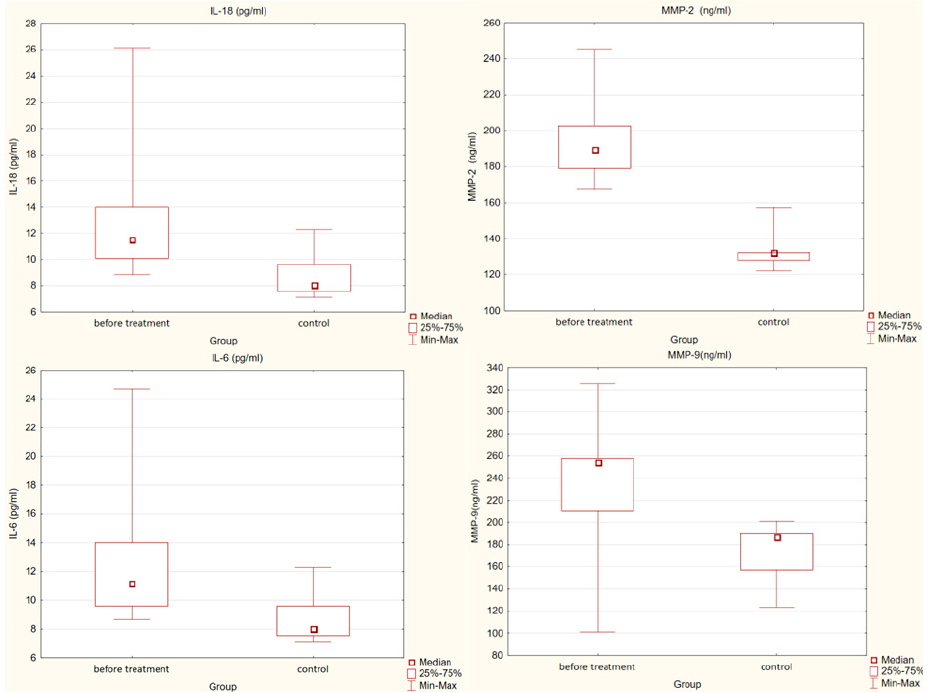
Figure 1. Differences in concentrations of interleukin 18 (IL-18), interleukin 6 (IL-6) ( p < 0.01), metalloproteinase 2 (MMP-2) ( p < 0.001) and metalloproteinase 9 (MMP-9) ( p = 0.001) in the study and control groups.